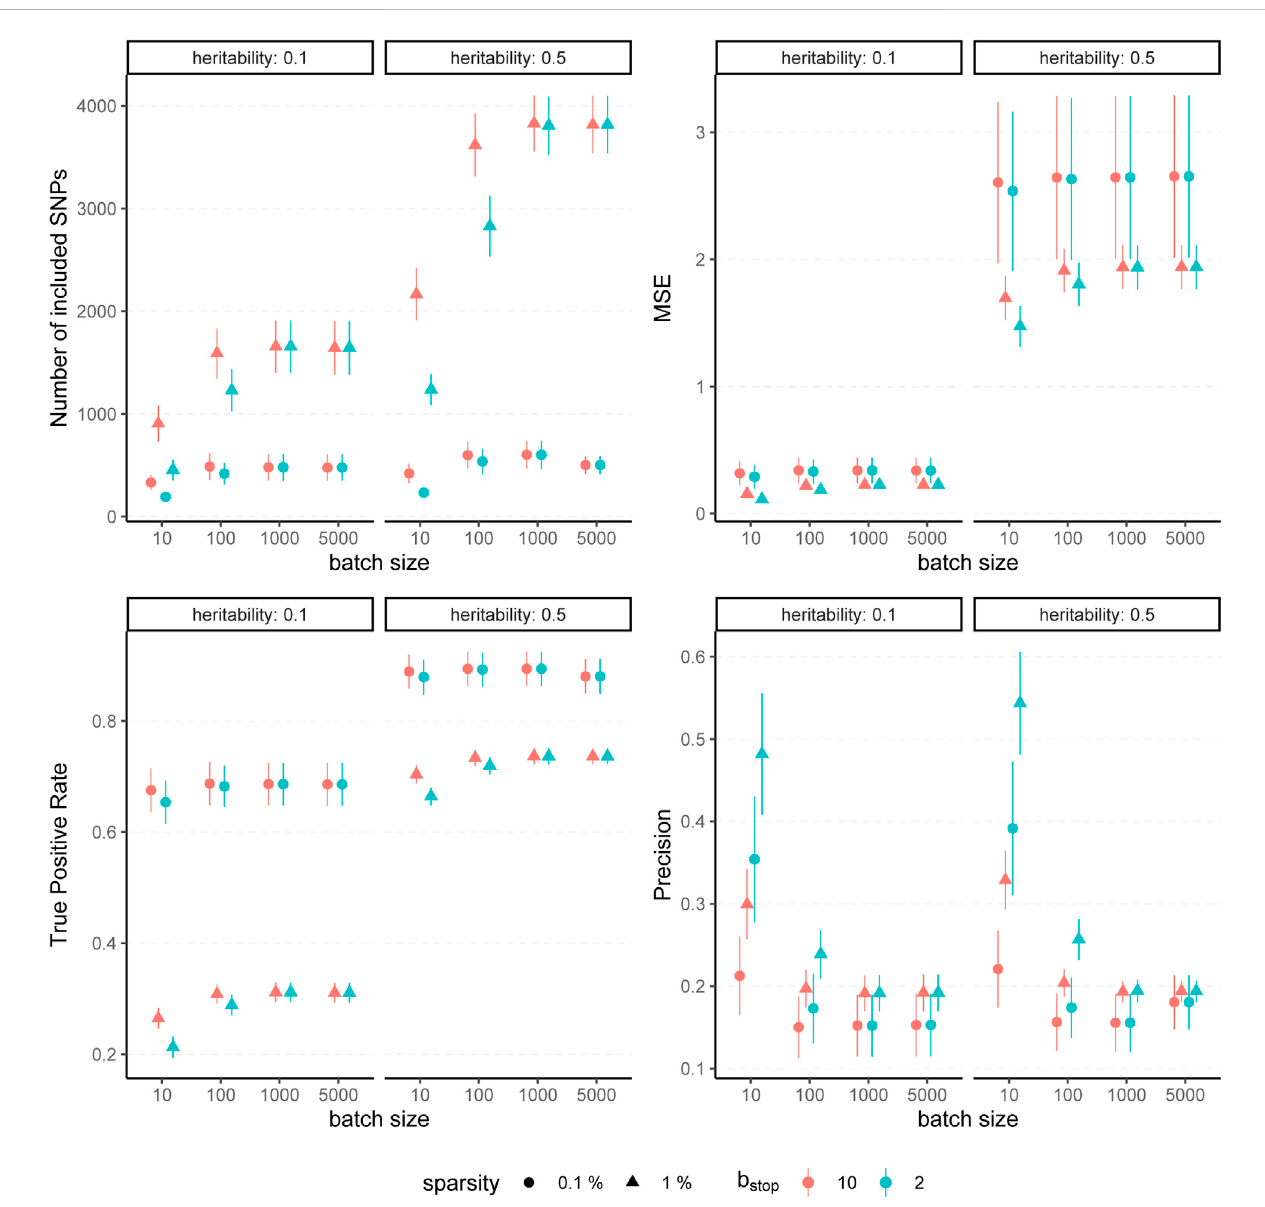
FIGURE 4 Evaluation metrics of the estimated coef fi cients for varying batch size and stopping criteria. Results of 100 simulated phenotypes with heritability h 2 ∈ {10%,50%},sparsity s ∈ {0.1%,1%}and